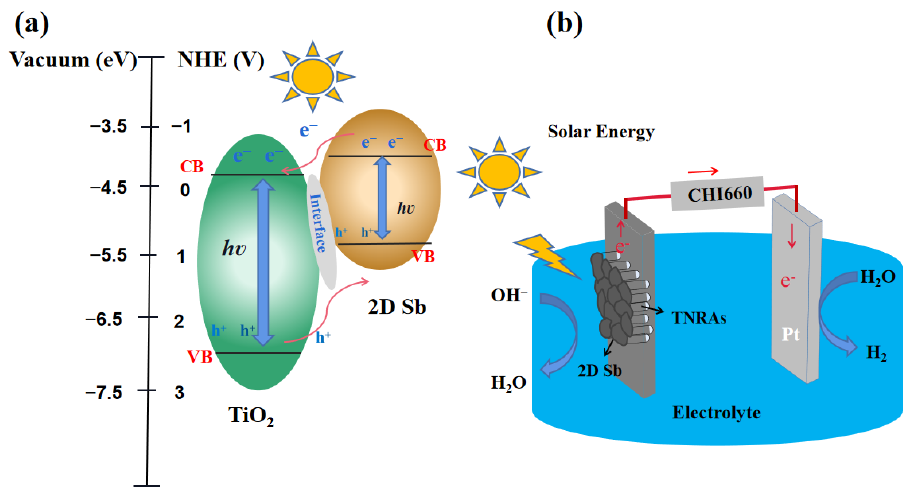
Figure 6. ( a ) Schematic diagram for the separation of photogenerated electron-hole pairs and the charge transfer process in a 2D Sb/TNRAs heterojunction system. ( b ) Schematic illustration of photoelectrochemical water-splitting process over the 2D Sb/TNRAs system. Conduction band (CB) and valence band (VB) edges for TiO 2 and 2D Sb were taken from the literature [24,26].